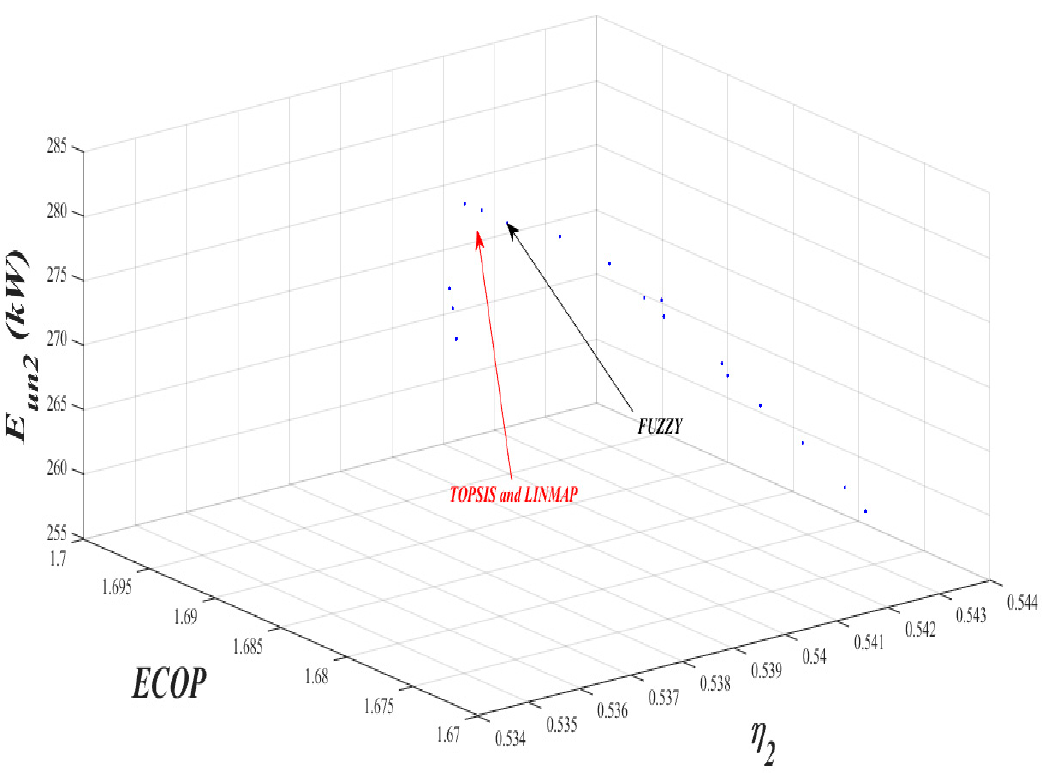
Figure 11. Distribution of the Pareto optimal frontier.